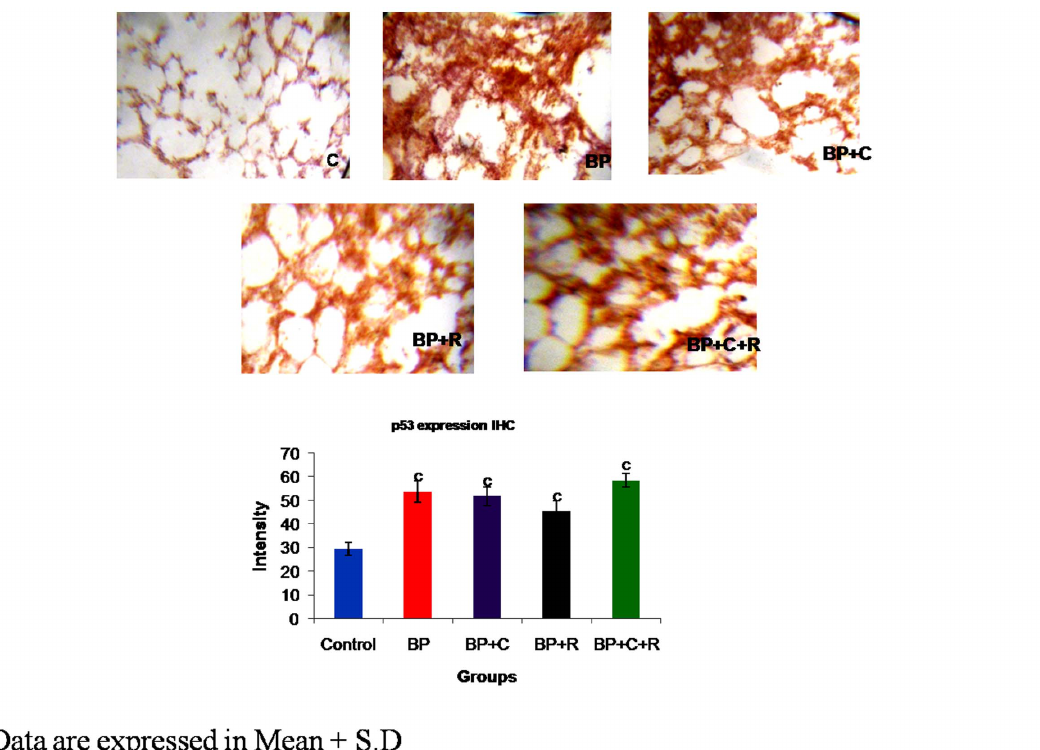
Figure 3. Effects of curcumin and resveratrol on protein expression of p53 by Immunhistochemistry [IHC at 10 6 magnification] during lung carcinogenesis.